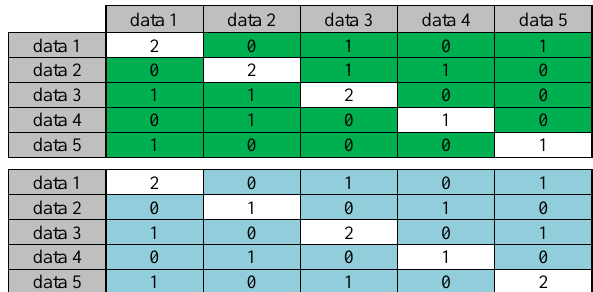
Table 2. Adjacency matrices for scenario A (green) and B